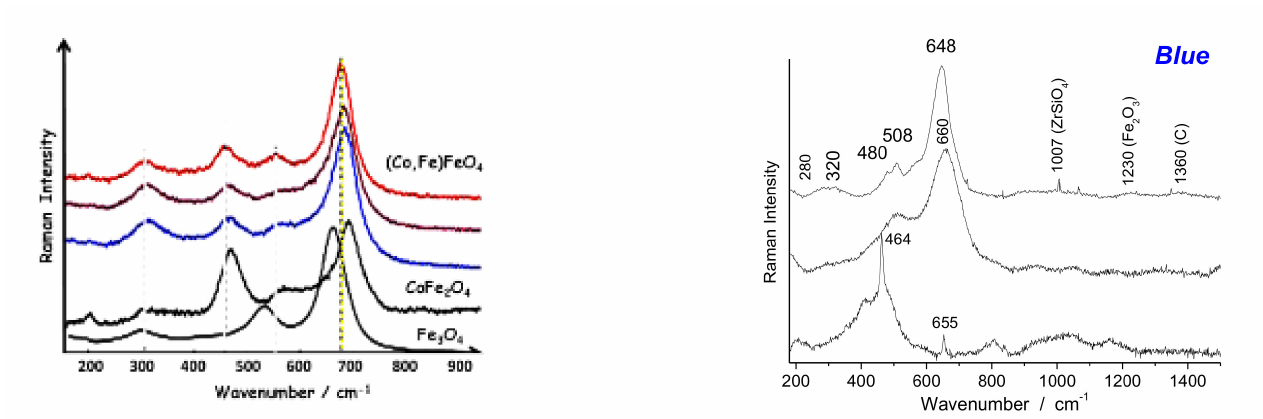
Figure 11. Examples of the Raman spectra of spinels with different compositions (left and right). Note the shift of the main M-O stretching mode between ~655 and 720 cm − 1 (redrawn after [204] data). Right, the top spectra represent the blue (Co-Fe-Mn) spinel signature measured on blue-and-white underglaze decorated sherds (excavated from Qalhat, the Sultanate of Oman, 14th–16th-Centuries [21]), with traces of zircon, hematite; the contribution of the glaze (plus quartz) is shown below.